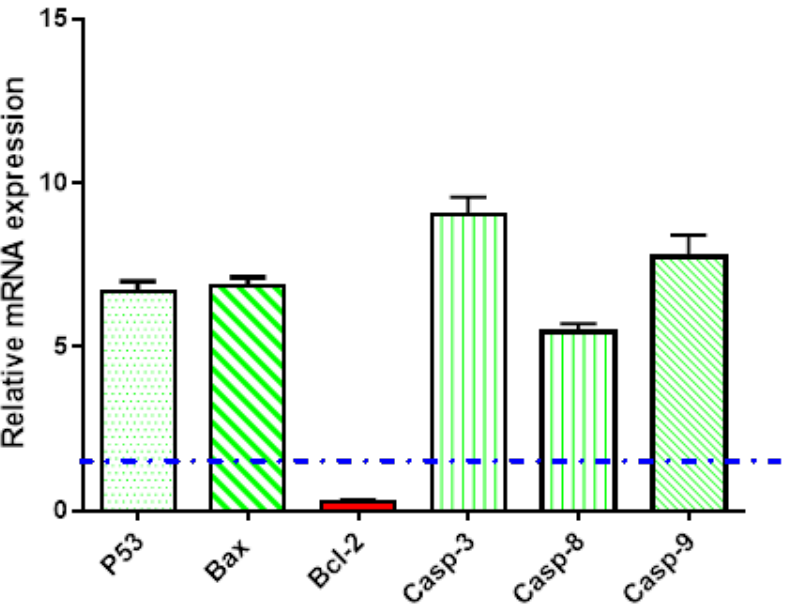
Figure 6. Gene expression analysis of untreated and treated PC-3 cells with Nano-TP/Flowers (IC 50 = 0.85 µ M, 48 h). β -actin was used as a housekeeping gene. Fold of change is calculated by 2 − ∆∆ CT , where ∆∆ CT is the difference between mean values of genes CT values in the treated and control groups. Blue dashed line represents fold of change of untreated control = 1.